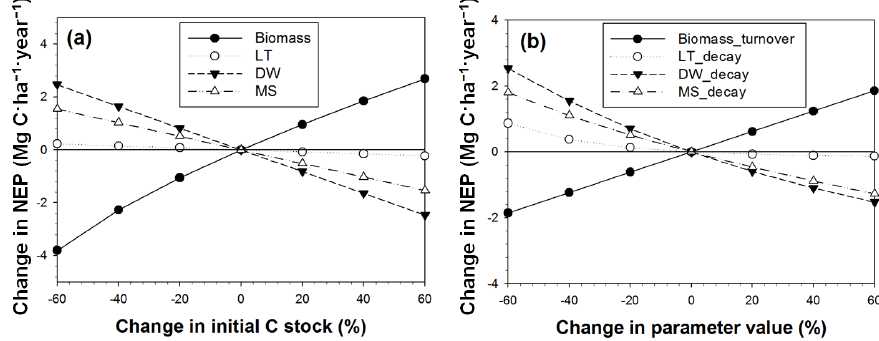
Figure 2. The sensitivity of NEP to changes in the ( a ) initial C stocks and ( b ) parameter values. Abbreviations: NEP, net ecosystem production; LT, litter; DW, dead wood; MS, mineral